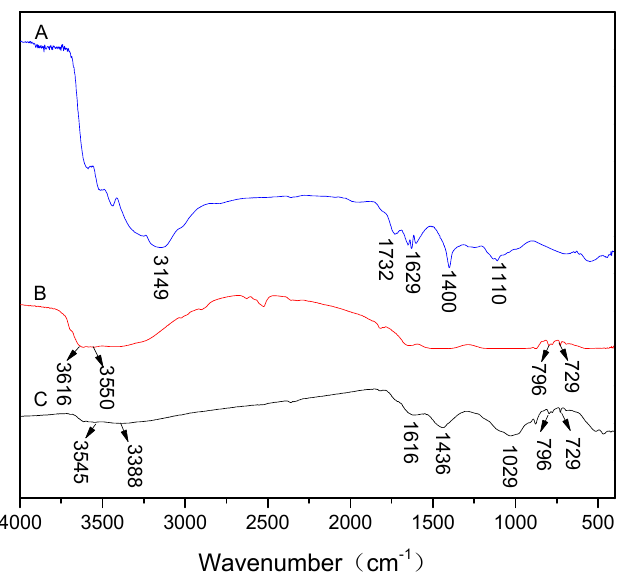
Figure 3. Fourier transform infrared spectroscopy (FTIR) spectra of ( A ) GO, ( B ) ATP, and ( C ) as-prepared GO.